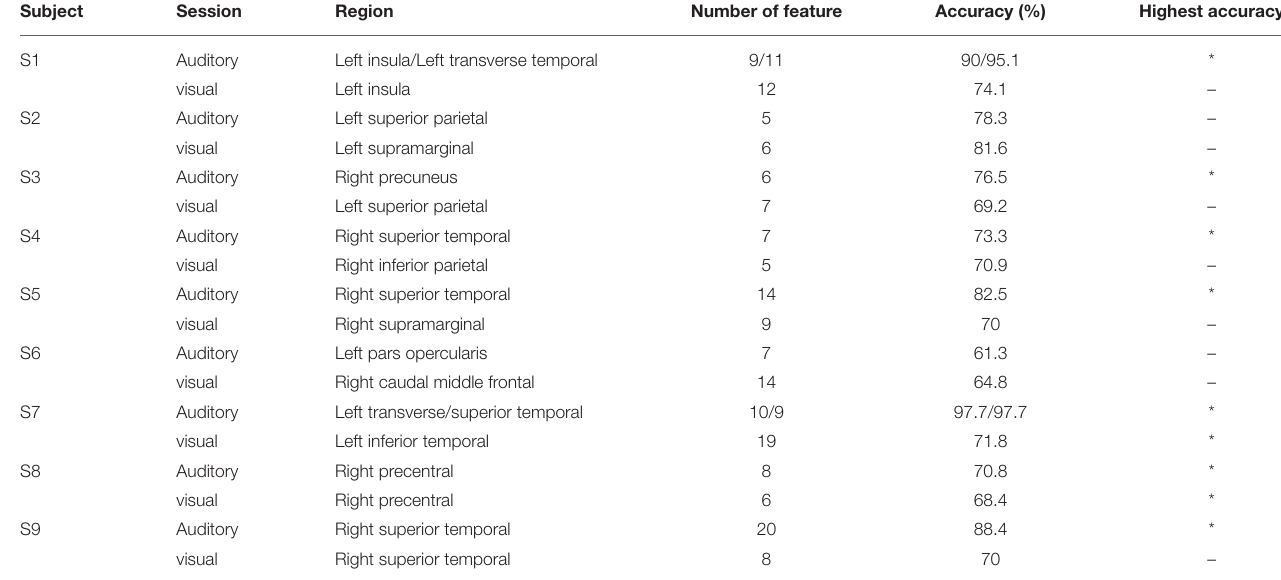
TABLE 2 | Regions providing maximum features in each